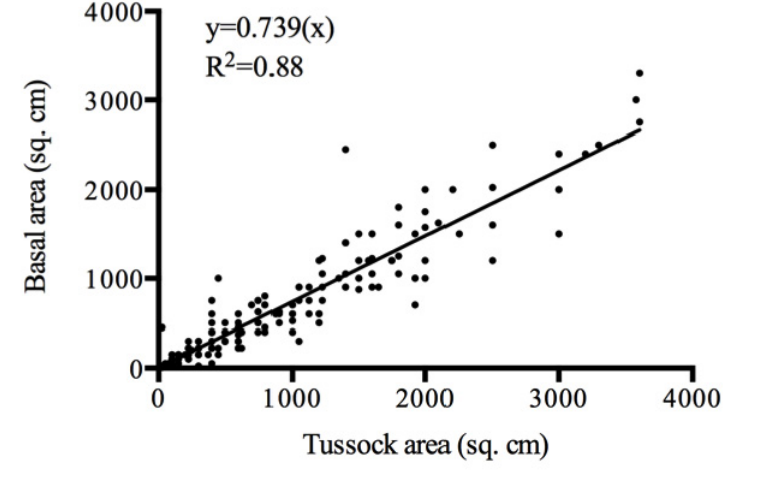
Figure 3. Relationship of E . vaginatum tussock area to basal area estimated in the